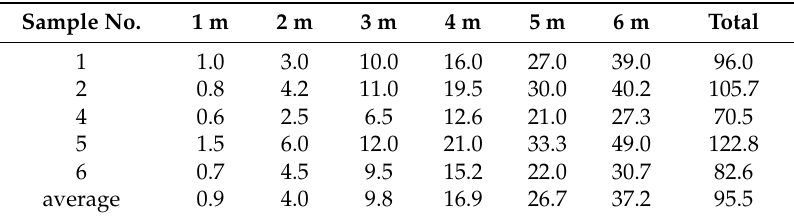
Table 5. The average number of bamboo in concentric circles of different radii with a broad-leaved tree at the center.